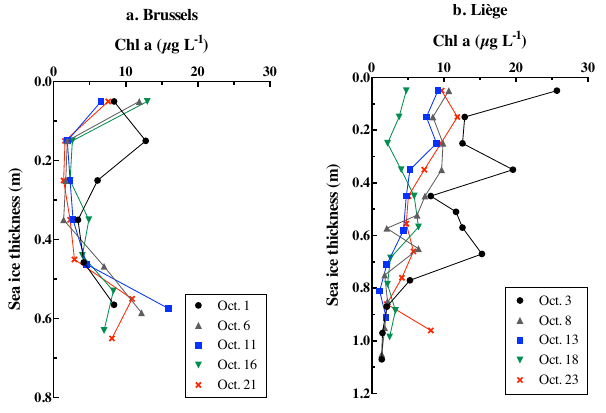
Figure 9. Profiles of Chl a concentration within bulk sea ice at the Brussels and Liège sites, adapted from Dumont